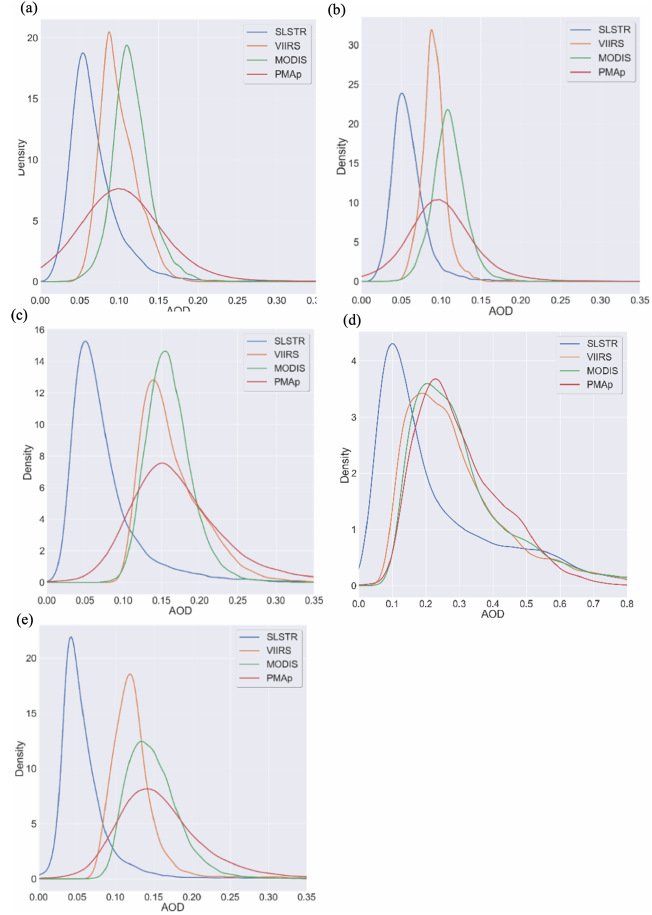
Figure C1. AOD distributions over distinct ocean regional domains for the DJF period. (a) North Atlantic, (b) North Pacific, (c) South Pacific, (d) mid-Atlantic, and (e) southern Indian